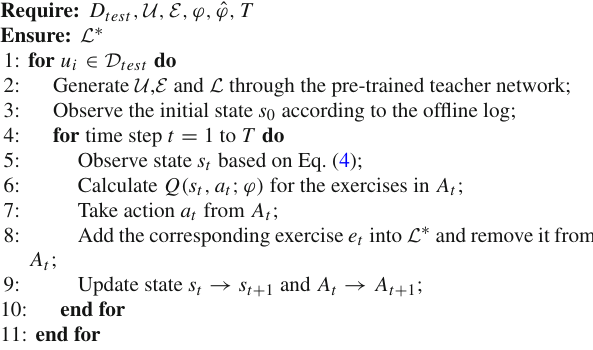
Algorithm 2 Testing Algorithm of TERD